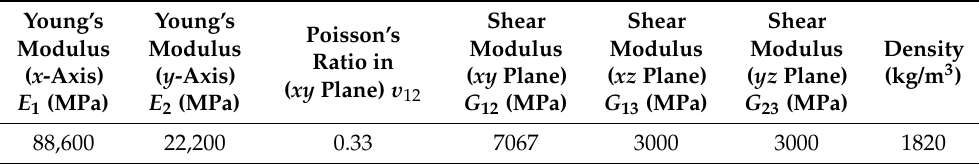
Table 5. Elastic properties of CFRP